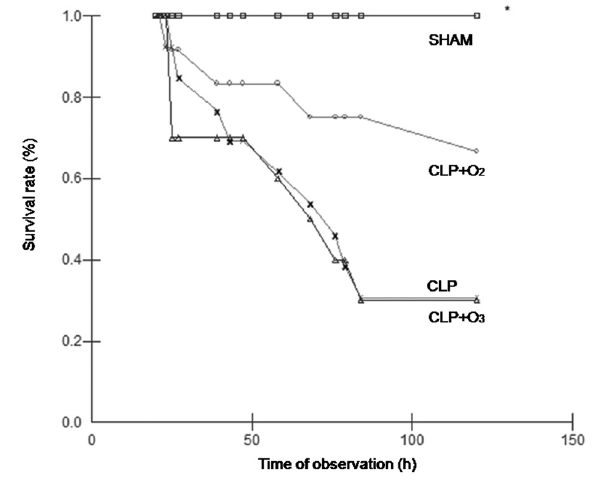
Figure 4 - Log – rank test. The observation period was not completed on only one animal from group SHAM. All of the other groups had a decreased survival time compared to group SHAM ( p =0.002). There were no differ- ences in survival among groups CLP, CLP+O SHAM;  =CLP;  = CLP+O